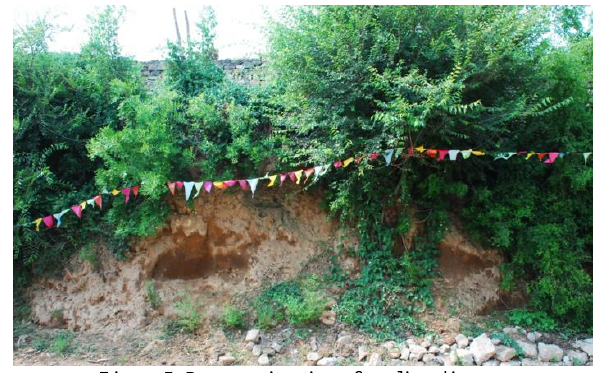
Figure 5. Present situation of peeling diseases of the south town wall.